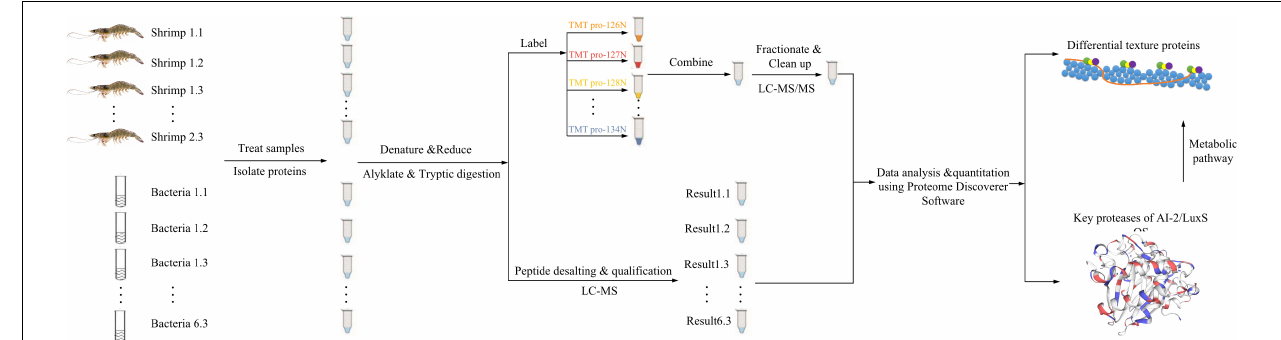
FIGURE 1 | Flowchart of proteomic